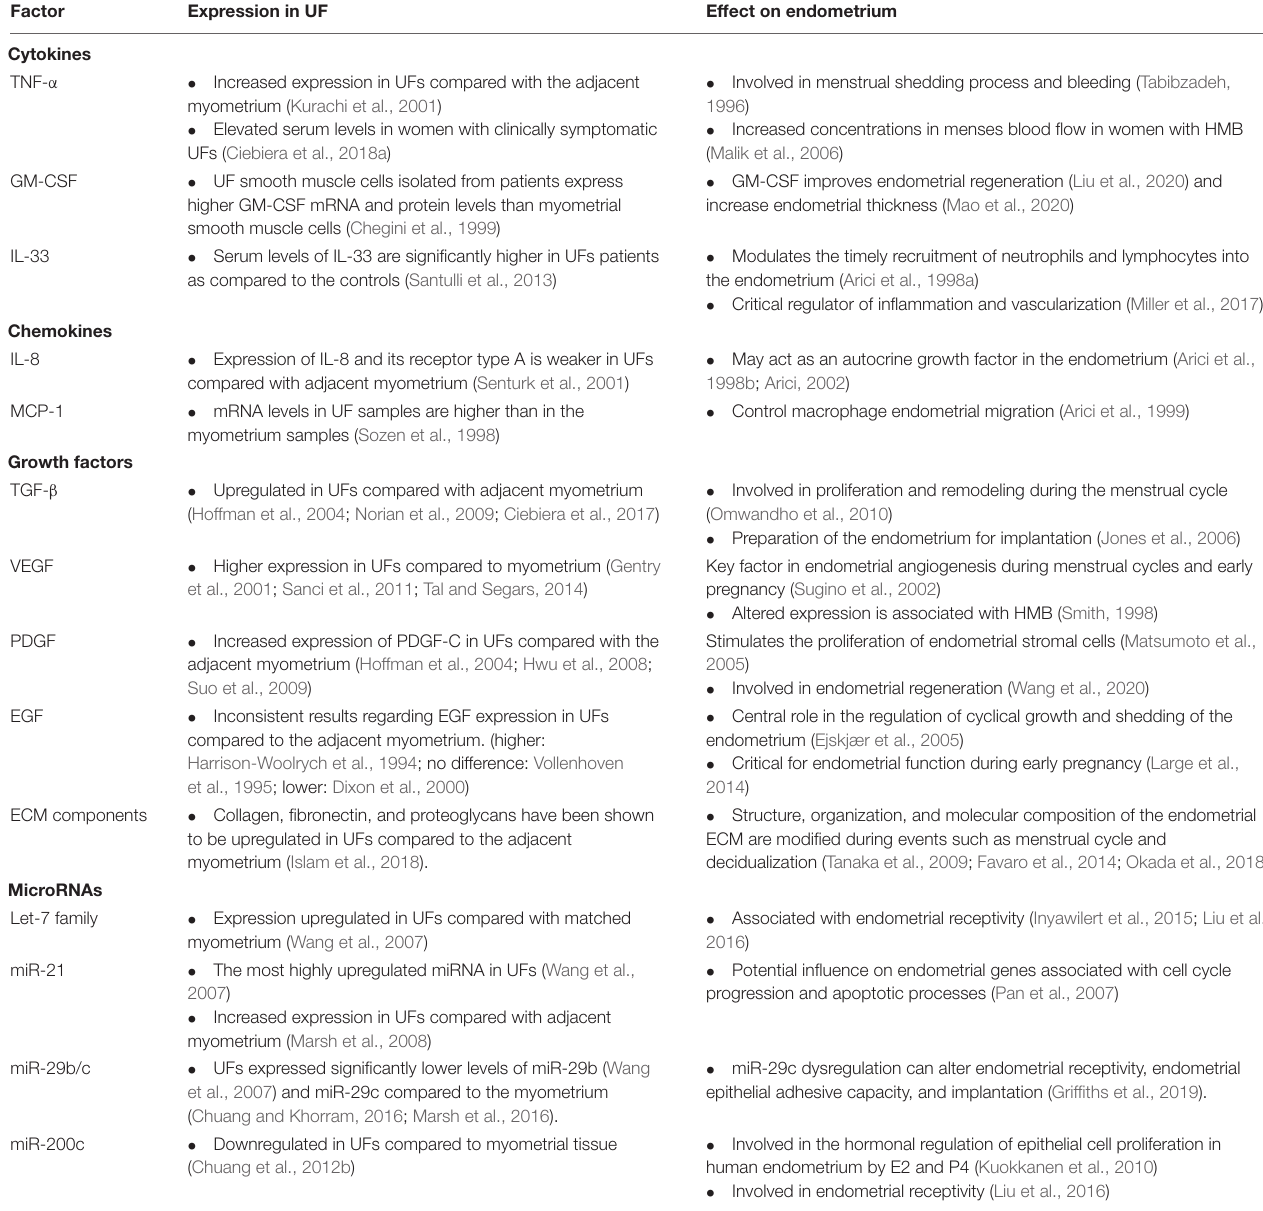
TABLE 1 | Differential expressions of the factors involved in uterine fibroid (UF) development and growth and its effect on the endometrium. Factor Expression in UF Effect on endometrium